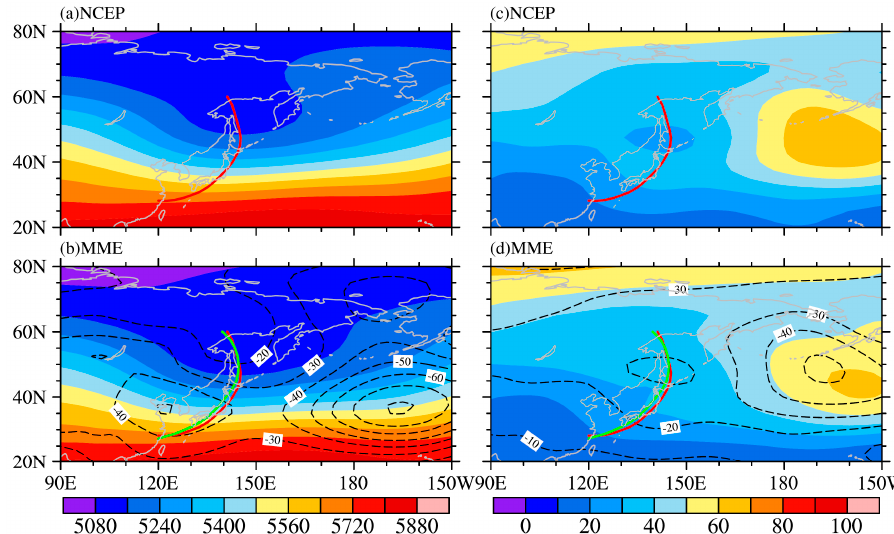
Figure 1. ( a ) Climatological mean of the geopotential height at 500 hPa and ( c ) its interannual standard deviations in the boreal winter based on observations (unit: gpm); ( b , d ) As in ( a , c ) but for the multimodel ensemble (MME) of the 12 CMIP5 (Coupled Model Intercomparison Project phase 5) models. The contours in ( b , d ) denote the differences between observations and MME. The red (green) lines represent the trough line in the observations (MME).